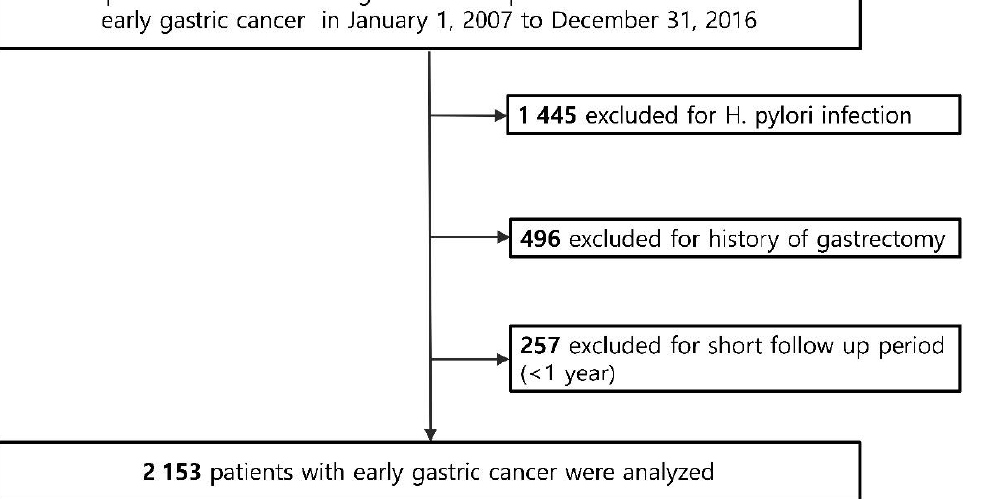
Figure 2. Flowchart of patient enrollment